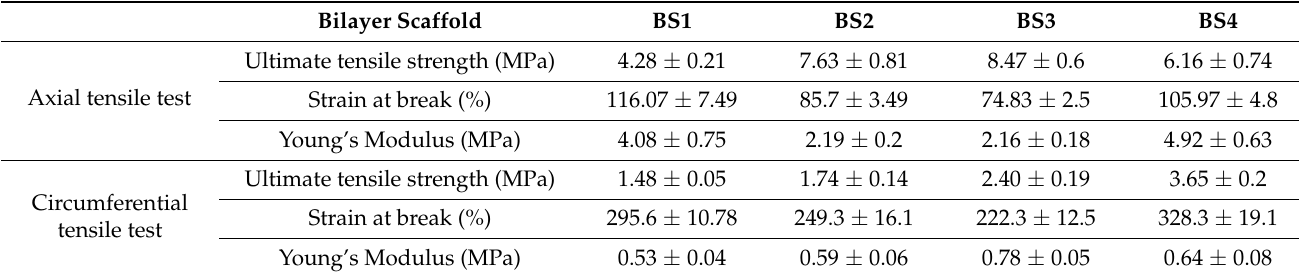
Table 2. Mean and standard deviation values of the mechanical parameters obtained by axial and circumferential tensile tests for four different bilayer scaffolds (BS1, BS2, BS3, and